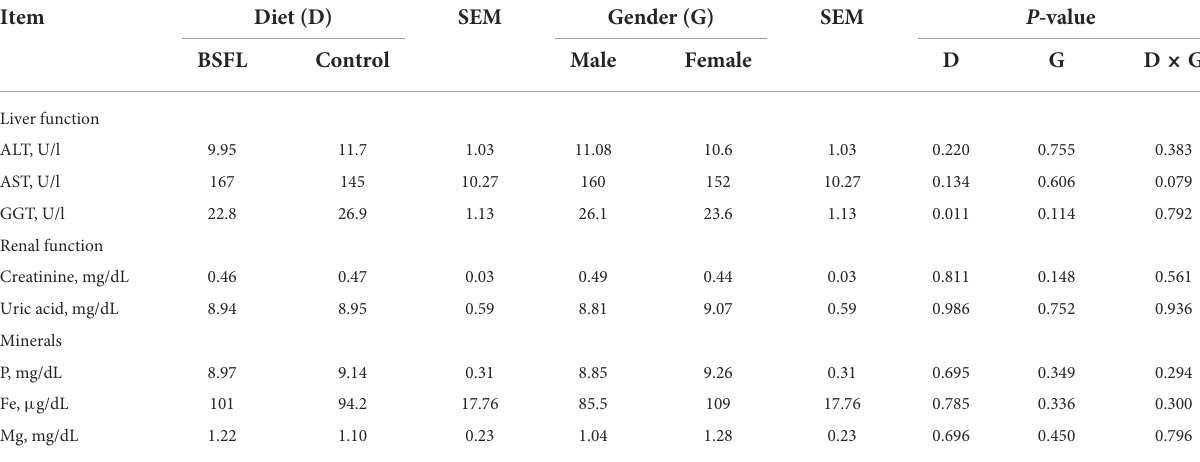
TABLE 6 The serum minerals and the liver and renal functions of the male and female Label Rouge Naked Neck birds fed a diet supplemented with 10% live black soldier fly larvae; supplementation based on the expected daily feed intake (28–81d; n = 12).